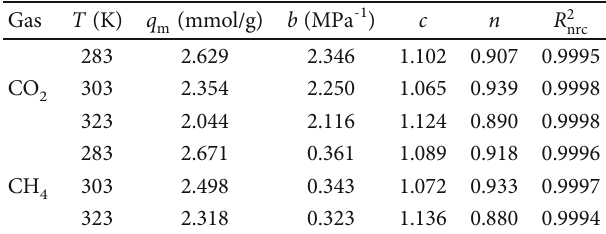
Figure 5: Simulated results of the adsorption isotherms using the L-F model: (a) CO Table 4: Fitting parameters of the L-F model of the isotherms of CO and CH 2 4